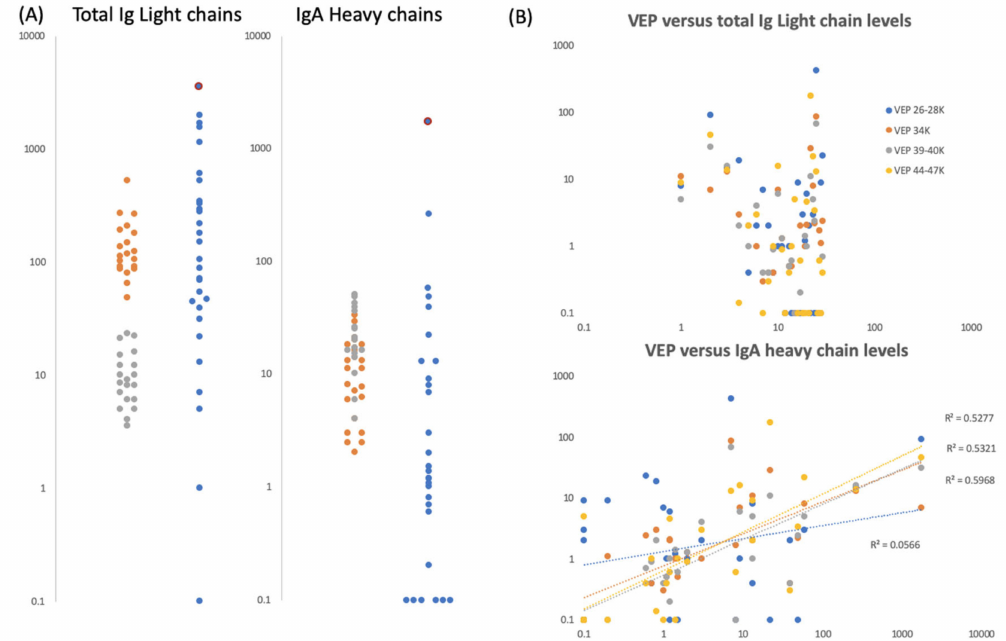
Figure 6. Gargle / saliva Immunoglobulin protein levels. Panel ( A ) are plots comparing the total Ig light chain and total IgA heavy chain peak intensity levels for two COVID-19 PCR negatives control individuals (grey and orange dots respectively) repeated 20 times each ( n = 40), versus the same peaks intensity level of 30 volunteers (blue dots) who gave gargle / saliva samples but whose COVID-19 PCR status was unknown at the time. Blue dots bound by a red circle are the levels of total Ig light chains and IgA heavy chains found in volunteer ID2. Panel ( B ) are scatter plots of total Ig light chains (upper plot) and IgA heavy chain peak intensities (lower plot) versus VEPs peak intensities for the 30 volunteer gargle / saliva samples but whose COVID-19 PCR status was unknown at the time. No VEP level correlated with total Ig light chain level. Correlation were seen with Ig A heavy chain levels for vep39–40K (grey dots r 2 = 0.60), vep44–47K (gold dots r 2 = 0.53) and vep34k (orange dots r 2 = 0.53) but not for vep26–28k (blue dots r 2 =